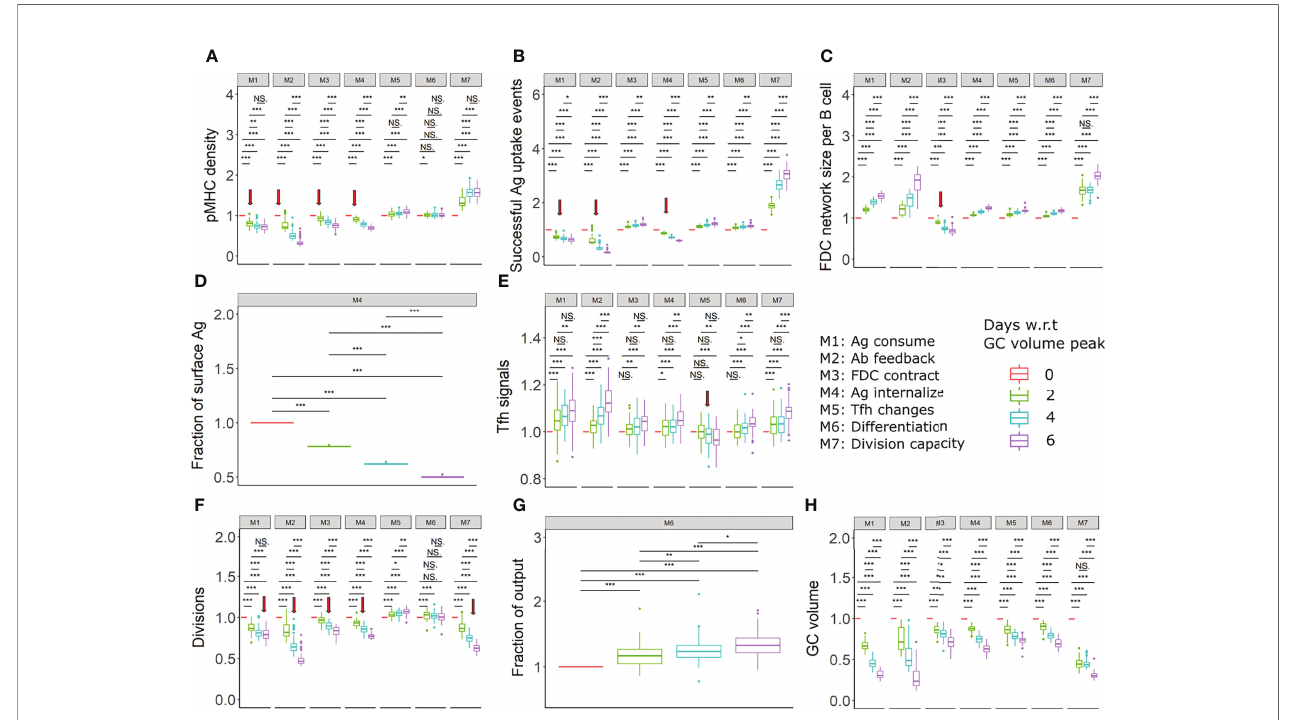
FIGURE 6 | Proposed experiments to identify the existence of mechanisms (in assumption A1). (A) pMHC density of selected centrocytes, (B) Fraction of successful antigen uptake events among all FDC-B cell encounters, (C) FDC network size per B cell, (D) Fraction of Ag on FDC surface, (E) Tfh signals received by selected centrocytes, (F) Average number of divisions of recycling centrocytes, (G) Fraction of output cells among Tfh selected cells, (H) GC volume in all mechanisms. All readouts were normalized with respect to (w.r.t) the value at the peak of the GC reaction. Different colors represent the different time points with respect to GC reaction peak. The FDC network size per B cell was calculated by dividing the total number of lattice sites occupied by FDCs by the total number of GC B cells. Statistical tests were performed by Wilcoxon test. Error bars represent standard deviation of 50 simulations. Red arrows indicate a decreasing trend in readouts that differs from other mechanisms. Parameter values used in different mechanism: M1: 1 unit of Ag consumption per FDC-B cell interaction, M2: N =300, M3: FDC contraction rate = 0.166 µm per hour, M4: K ext =150, M5: K T = 600, M6: k = 0.003, M7: K K = 5. GC, Germinal center; Tfh, T follicular helper cell; Ag, Antigen; Ab, Antibody; FDC, Follicular dendritic cell. * = p < 0.05, ** = p < 0.01, *** = p < 0.001. NS, not signi fi